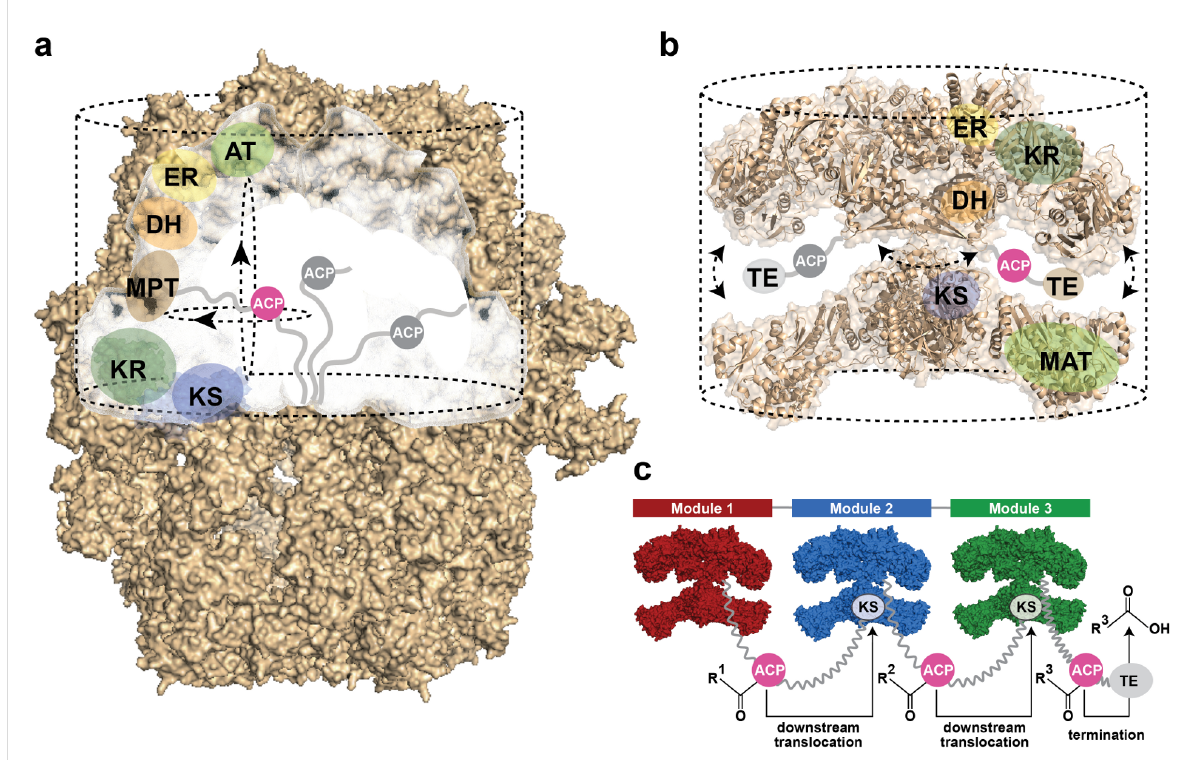
Figure 2: Compartmentalization of synthesis. a) Surface depiction of fungal FAS (PDB-code: 3hmj) with the upper reaction chamber shown without the front part of the barrel wall. One of overall three sets of catalytic domains within a reaction chamber is indicated. Abbreviations as introduced before; additionally, acetyl transferase (AT) and malonyl-/palmitoyl-transferase (MPT). Two linkers, abstracted as grey lines, flexibly bind the acyl carrier protein (ACP) domain. The reaction volume was calculated as indicated by dashed lines. b) Cartoon representation of X-shaped animal FAS I (PDB-code: 2vz8) with one of overall two sets of catalytic domains highlighted. Abbreviations as introduced before; additionally, malonyl-/acetyl-trans- ferase (MAT) and thioesterase (TE). Conformational flexibility of animal FAS, as indicated by arrows, is largely induced by a central waist. The reac- tion volume was calculated as cylinder as indicated by dashed lines. c) Model of a modular PKS assembly line. Modules 1–3 are depicted in an animal FAS I-like fold. Linkers, covalently or non-covalently connecting modules in modular PKS, are abstracted with zig-zag lines carrying also ACP. Only one of the two ACP domains per homodimeric module is shown for clarity. Each ACP acts in cis for substrate elongation (see Figure 2b) and in trans for substrate